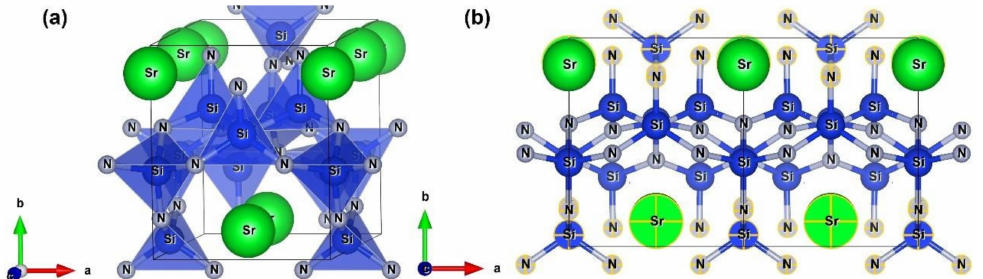
Figure 9. ( a ) Molecular structure of Sr 2 Si 5 N 8 ; ( b ) 2 × 2 × 1 supercell of Sr 2 Si 5 N 8 : The selected atoms are Sr 2